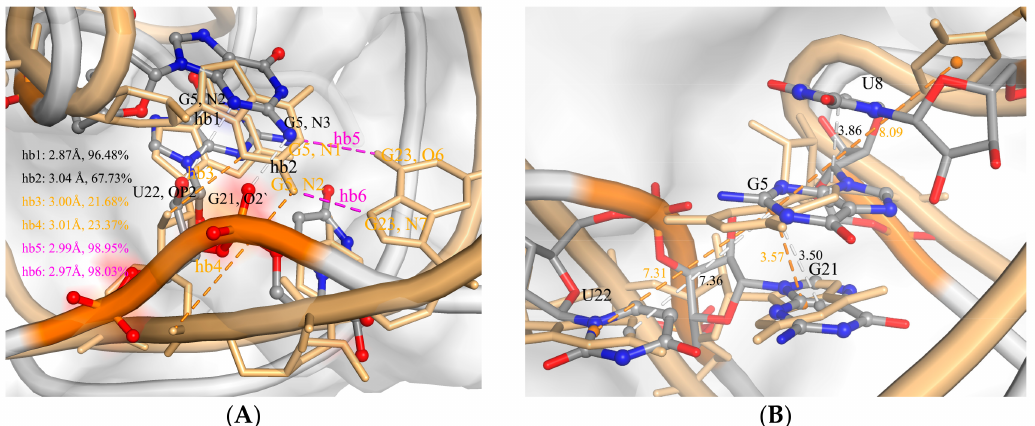
Figure 4. ( A ) The H-bonds formed for G5 in com-ToxI and in apo-ToxI. ( B ) The distances between the mass center of nitrogenous base of U8 and G5. The nucleotides are shown in ball and stick representation and colored with elements in com-ToxI, as well as stick representation in apo-ToxI. The H-bonds were determined by an acceptor ··· donor distance less than 3.5 Å and an acceptor ··· H donor angle larger than 120 ◦ . Occupancy was defined as the percentage of the snapshots from MD simulation trajectory where a specific hydrogen bond